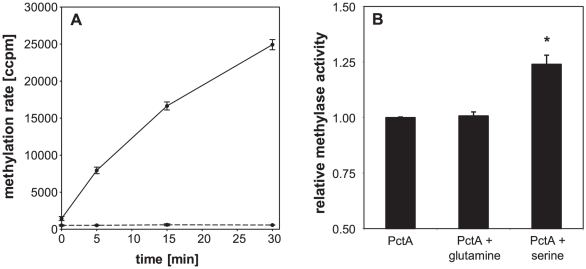
Methylation of the methyl-accepting chemotaxis protein PctA by CheR-His6 using [3H-methyl]-SAM as the methyl donor.(A) Methylation rate of E. coli HCB721 membranes containing no MCP (dashed line) or the P. aeruginosa MCP PctA (continuous line). (B) Methylation reactions carried out for 15 min in the presence of 1 mM serine resulted in an significantly increased methylation rate of the MCP PctA (* p<0.001, paired t-test), whereas the addition of glutamine had no effect. Representative data from one experiment out of at least two are shown. Error bars are standard deviations of three replica.